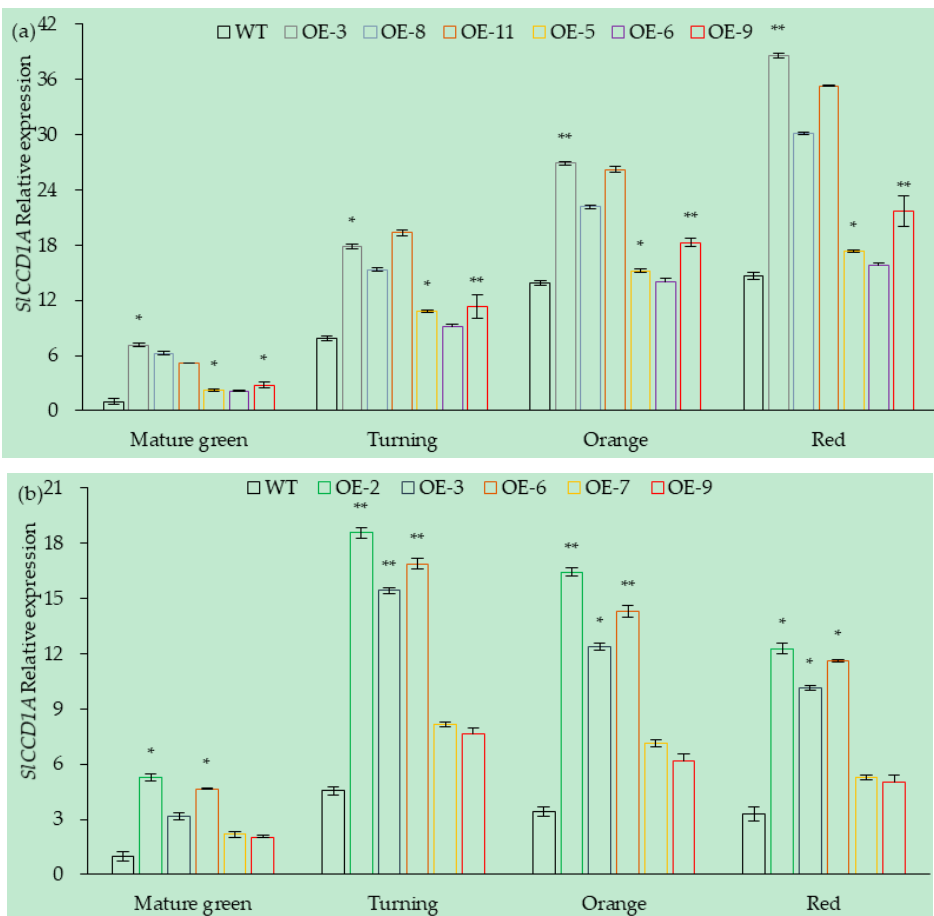
Figure 9. Relative expressions of SlCCD1A in OE tomato fruits in ( a ) CI1005 and ( b ) TI4001. WT: pVbg2307 empty vector; * indicates that SlCCD1A expression was significantly higher in OE lines than in WT ( p < 0.05); ** indicates that SlCCD1A expression was very significantly higher in OE lines than in WT ( p < 0.01).